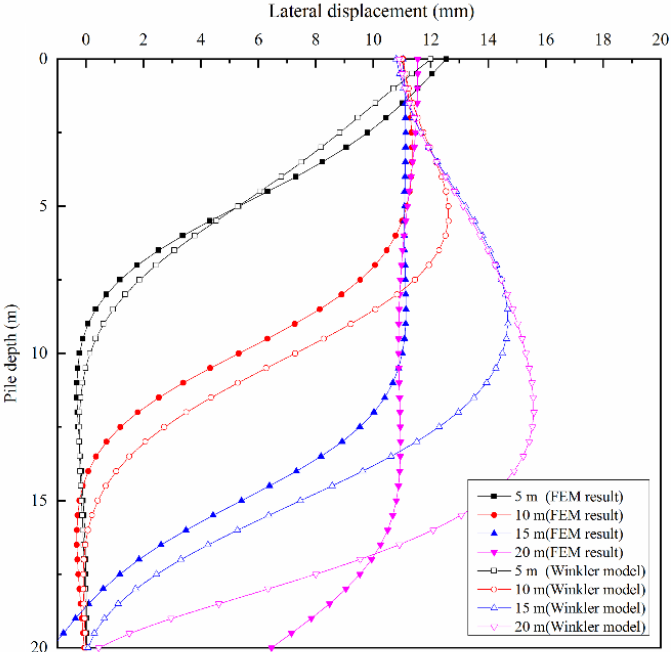
Figure 10. Comparison of calculation results between numerical simulation and Winkler foundation model with pile tip fixed.